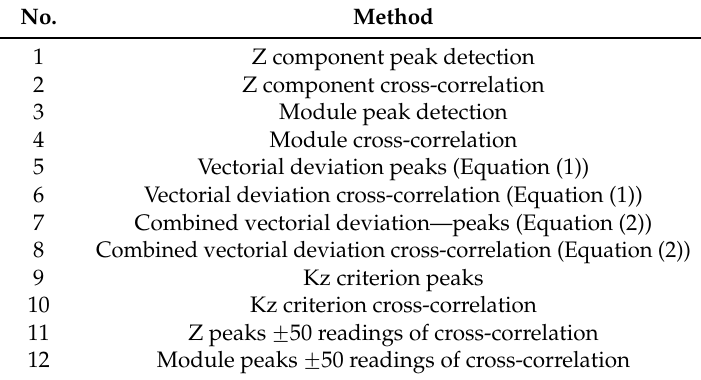
Table 1. List of methods.